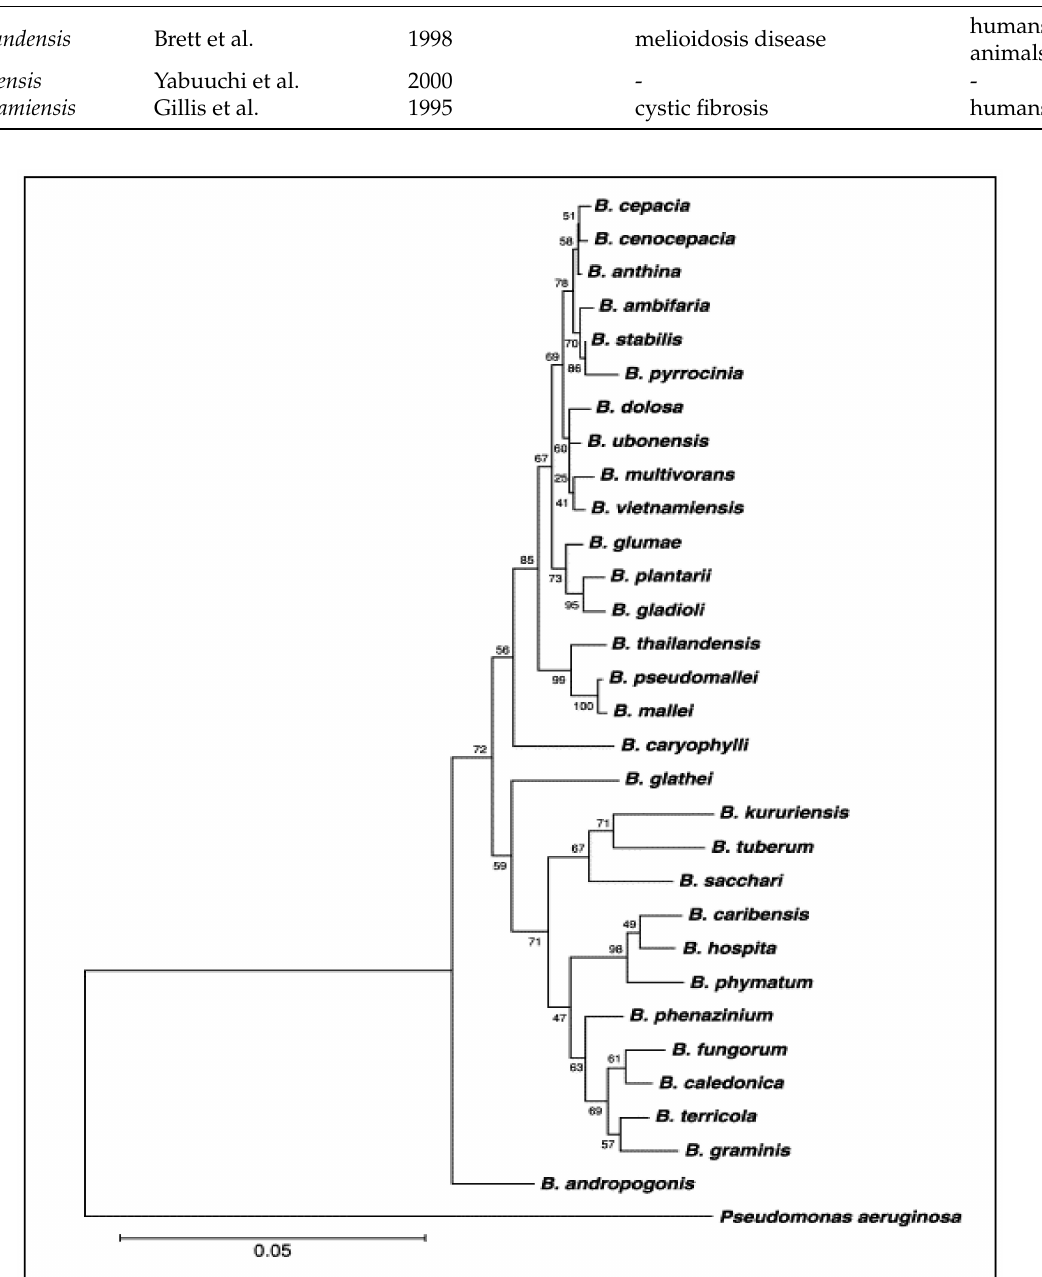
Figure 1. Phylogenetic tree of genus Burkholderia based on 16S rRNA gene sequence. This phylogenetic tree is in agree with Coenye and Vandamme